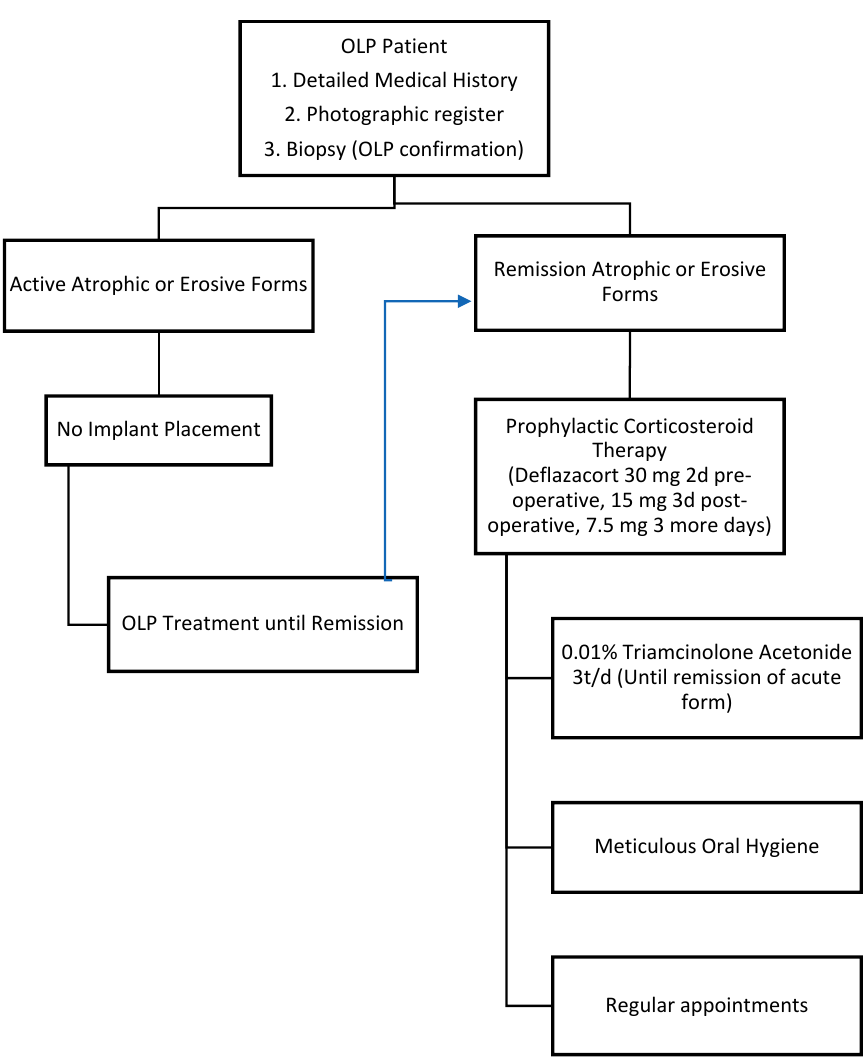
Figure 3. Protocol proposed by our workgroup.